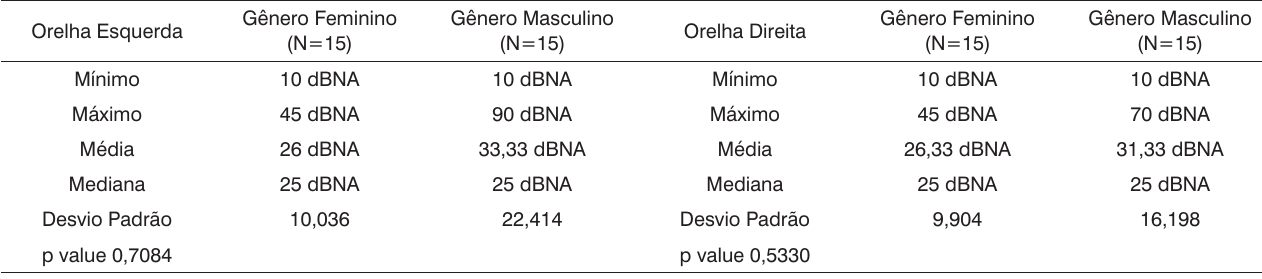
Tabela 1. Descrição dos valores de ATL, segundo